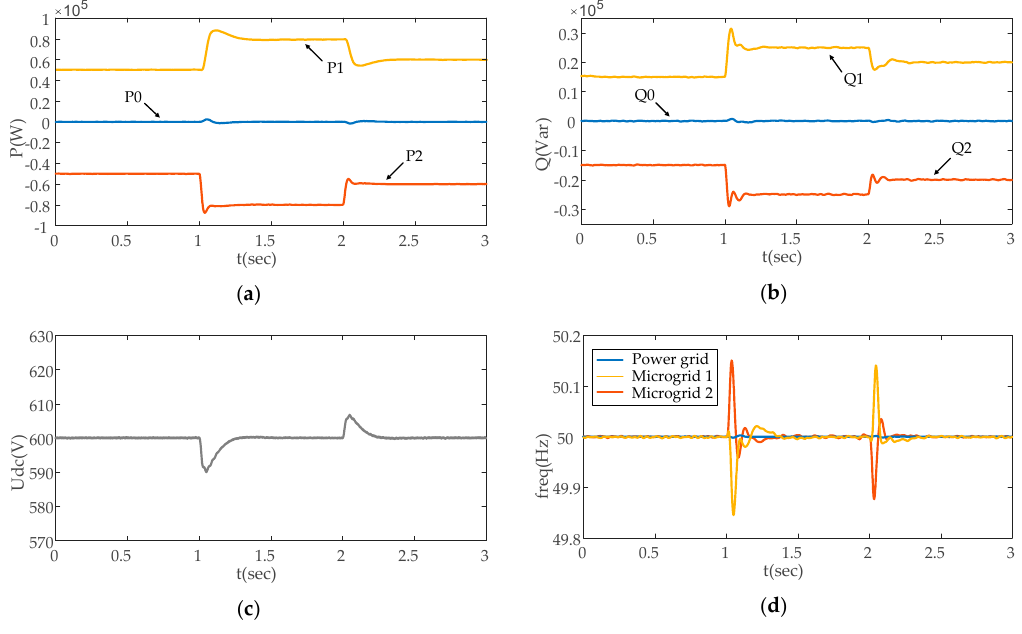
Figure 11. Simulation results of scenario 1: ( a ) active power curves; ( b ) reactive power curves; ( c ) DC-link voltage curves; and ( d ) frequency curves.